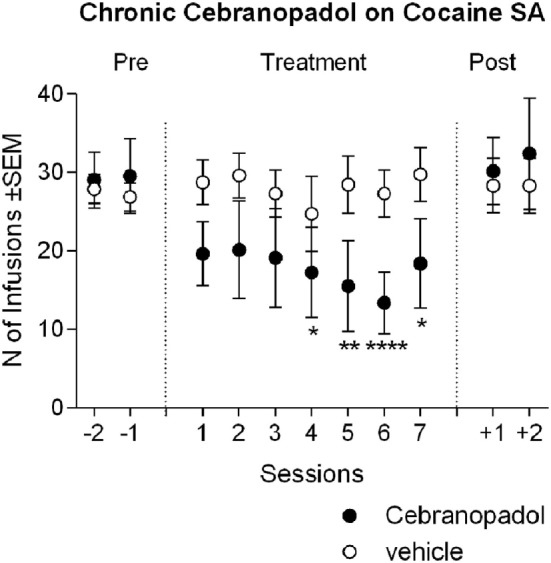
Chronic cebranopadol treatment on cocaine self-administration. Two groups of rats with similar baseline of cocaine intake received cebranopadol (25 µg/kg) or its vehicle for seven consecutive sessions. The number of cocaine infusions earned by the cebranopadol-treated group decreased during treatment in respect to baseline, and returned to pretreatment level from the first day posttreatment. In the vehicle-treated group, cocaine self-administration remained stable throughout the experiment. Data are presented as mean ± SEM and show the last 2 days of pretreatment, 7 days of treatment, and 2 days of posttreatment. Statistical differences: *p < 0.05, **p < 0.01, and ****p < 0.0001 vs. the last day pretreatment.